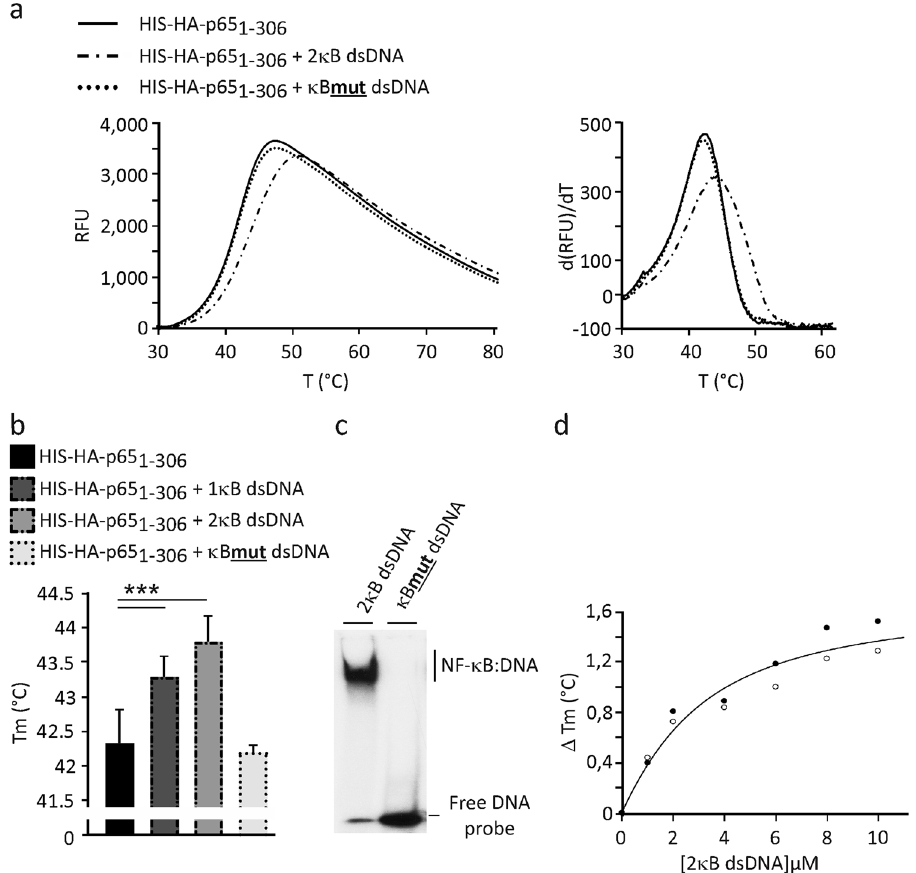
Figure 3. Detection of sequence-specific dsDNA binding to p65/RelA probe in the thermal shift assay. ( a , b ) The κB-dependent thermal stabilization of p65 1-306 probe in the presence of 10 µM dsDNA oligomers. Representative unfolding (left) and positive derivative (d(RFU)/dT) (right) curves are shown. Midpoint temperatures of the protein-unfolding transition (Tm) are presented as bars. Values are mean ± SD of at least three independent measurements (*** p < 0.001). ( c ) EMSA of p65 1-306 protein (0.5 µM) using 32 P-labelled 2κB and mutated κB consensus oligonucleotides (1 × 10 4 cpm). ( d ) Thermal stability shift assessed with varying 2κB dsDNA concentrations. ΔTm, change in Tm of p65 1-306 probe caused by dsDNA. The curve is based on two separate acquisitions shown as open and closed